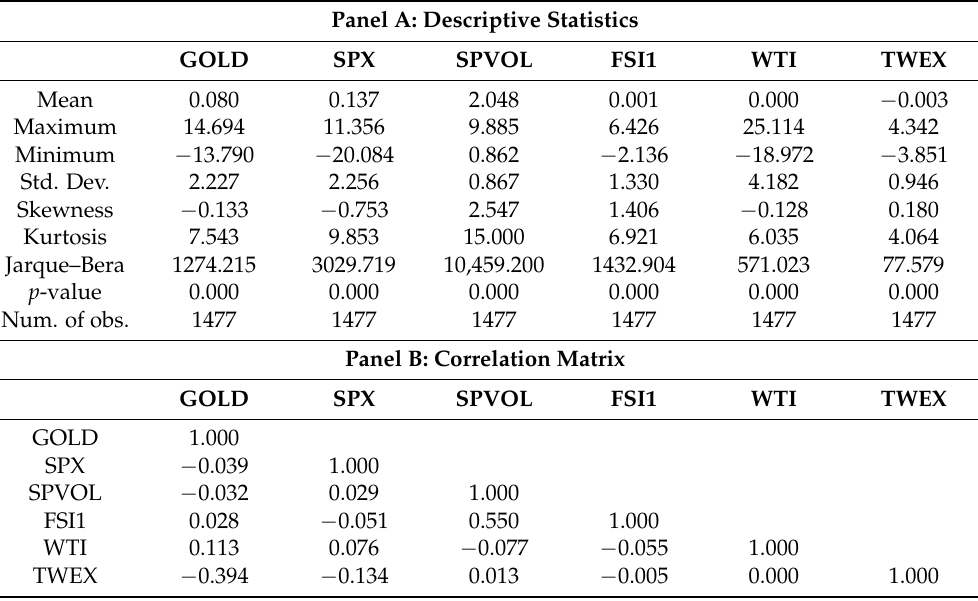
Table 3. Summary